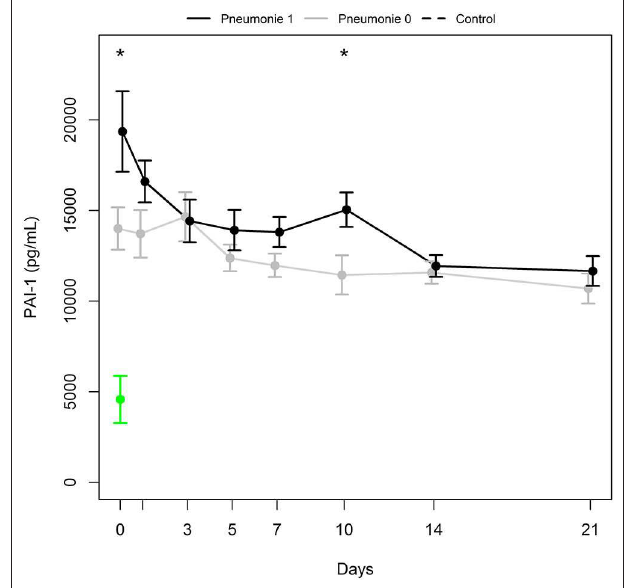
FIGURE 3 | Individual PAI-1 antigen levels (gray lines) and mean PAI-1 antigen level (black bold line) in the study group. Mean ± SEM of PAI-1 in healthy controls (green).